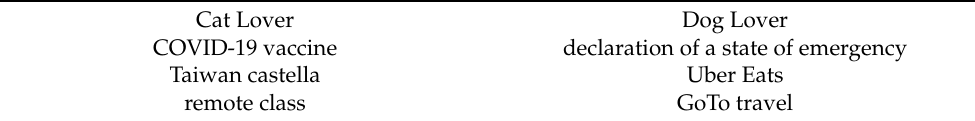
Table 1. Example of keywords for tweet collection.